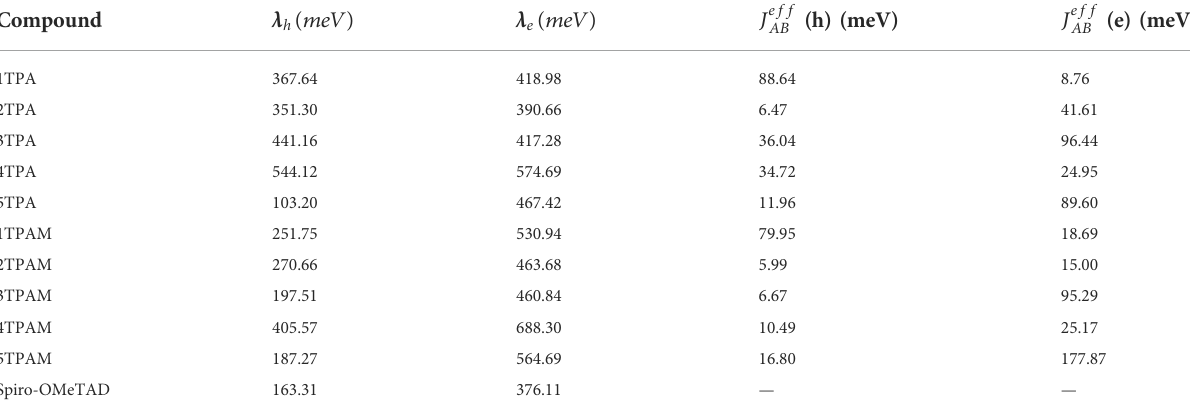
TABLE 5 Reorganization energies and electronic coupling values calculated for triphenylamine derivatives and Spiro-OMeTAD.